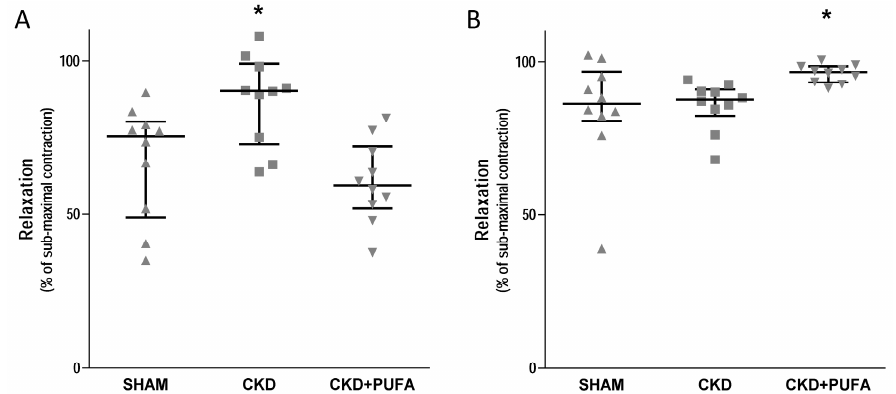
Figure 2. Effect of ex-vivo incubation with the antioxidant Tiron ( A ) and NOS inhibitor L-NAME ( B ) on acetylcholine (10 − 6 mol/L)-induced vasodilation in sham-operated (SHAM), 5/6 nephrectomized rats fed with standard diet (CKD) and fed with n 3-PUFA enriched diet (CKD + PUFA). Vascular reactivity studies were performed on segments of thoracic aortas. Submaximal contraction to phenylephrine (10 − 6 mol/L) was similar among groups. Median and interquartile range. * p < 0.05 vs. other groups. n = 10/group.